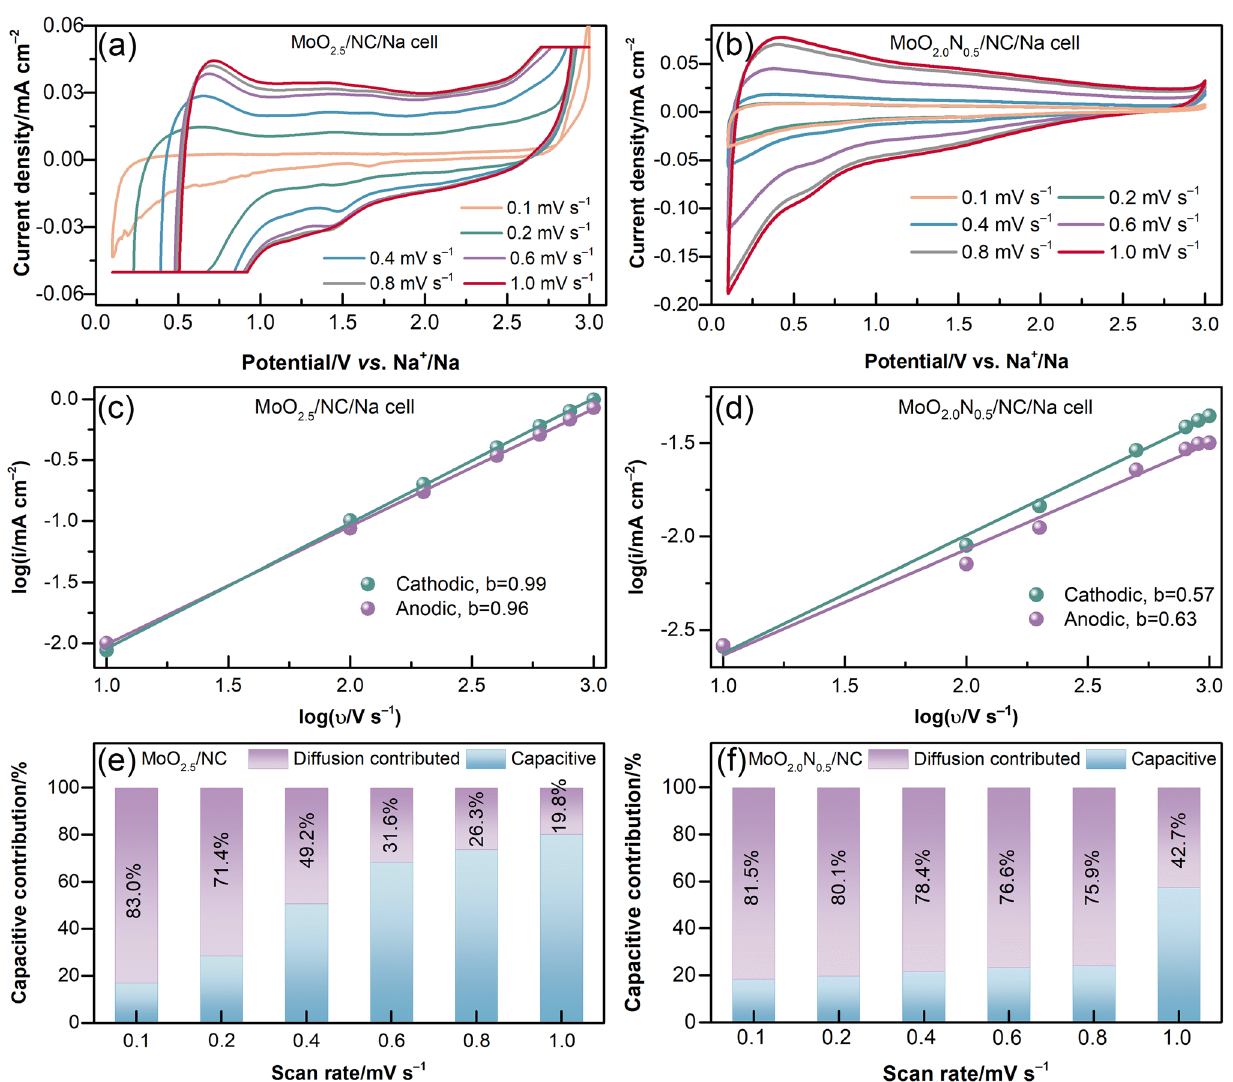
Fig. 4 Kinetics analysis of the MoO 2.5 /NC and MoO 2.0 N 0.5 /NC electrode. CV curves for a MoO 2.5 /NC/Na cells and b MoO 2.0 N 0.5 /NC/Na cells with a various scan rate. b -value analysis using the relationship between the anodic and cathodic peak currents and scan rates: c MoO 2.5 /NC and d MoO 2.0 N 0.5 /NC. Contribution ratio of the capacitive and diffusion-controlled at various scan rate for e MoO 2.5 /NC and f MoO 2.0 N 0.5 /NC